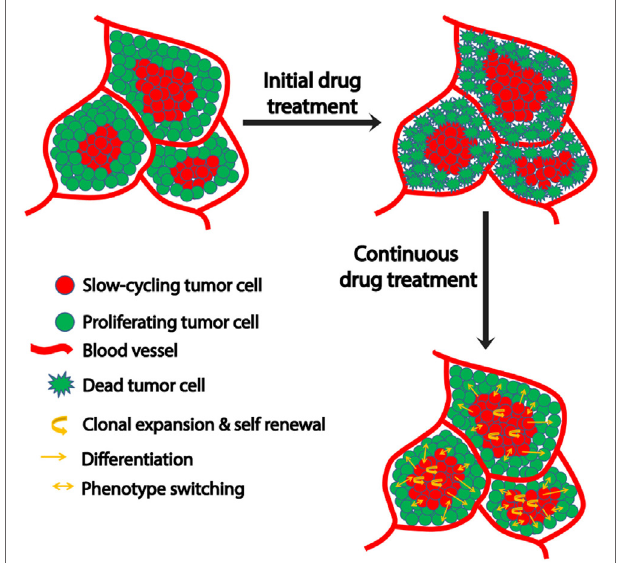
FiGURe 1 | Schematic representation of microenvironment-driven dynamic heterogeneity and phenotypic plasticity as a mechanism of melanoma therapy resistance. Tumor cells close to the blood vessels proliferate, while those away from blood vessels experience hypoxia and nutrient starvation that contribute to their slow-cycling phenotype. While treatment readily targets proliferating cells, slow-cycling cells can evade drug action and survive. Upon continuous treatment, this slow-cycling subpopulation is enriched within the tumor by clonal expansion. Due to their inherent cancer stem cell-like property, they are capable of self-renewal or differentiation into a proliferative tumor cells with increased drug resistance. In addition to this, the slow-cycling cells can switch their phenotype to fast proliferating cells upon exposure to oxygen and nutrients after replacing the original peripheral fast proliferating cells that had been killed by the therapy. These phenotype- switched cells might be more drug resistant too, as they might have acquired resistance during their slow-cycling